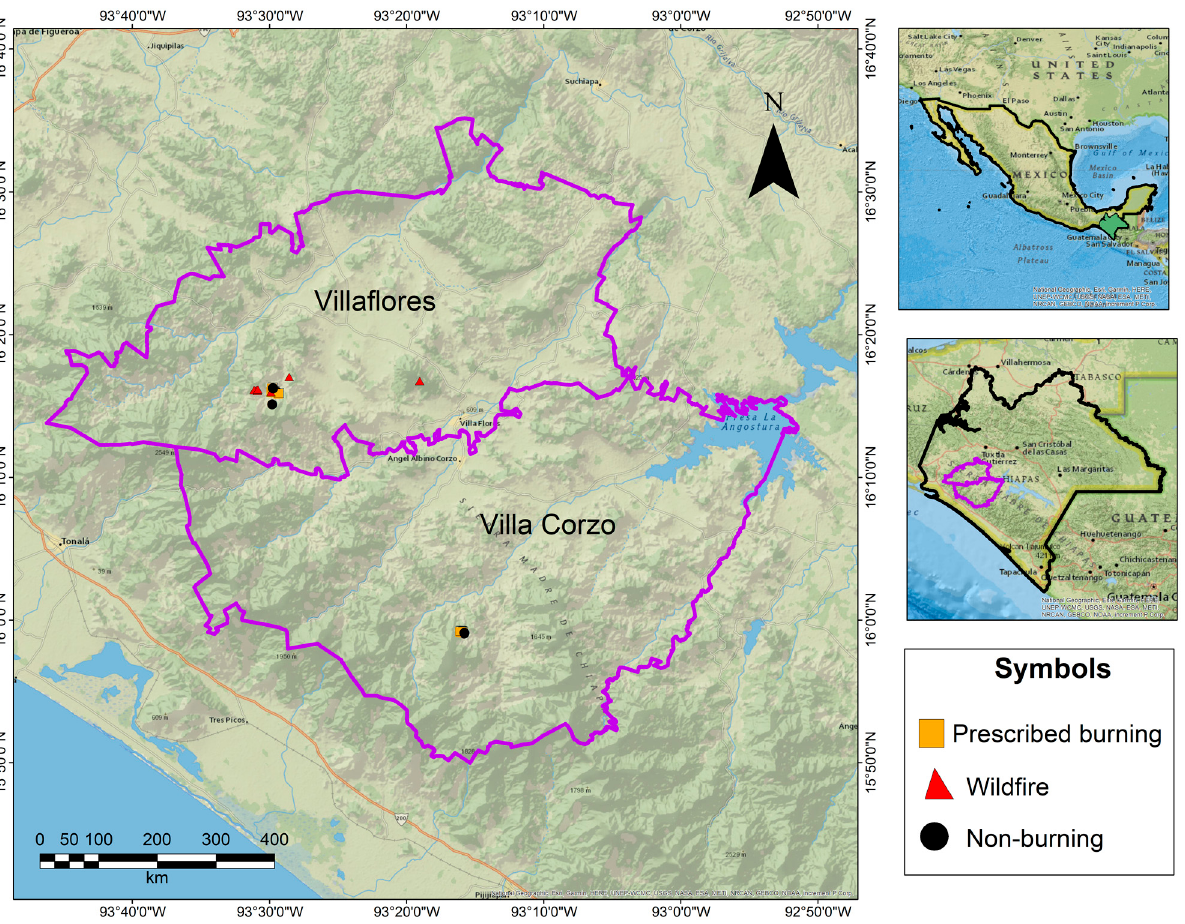
Figure 1. Location of the study area and distribution of sampling sites in two municipalities of Chiapas, southern Mexico. The area is a part of the Sierra Madre de Chiapas.